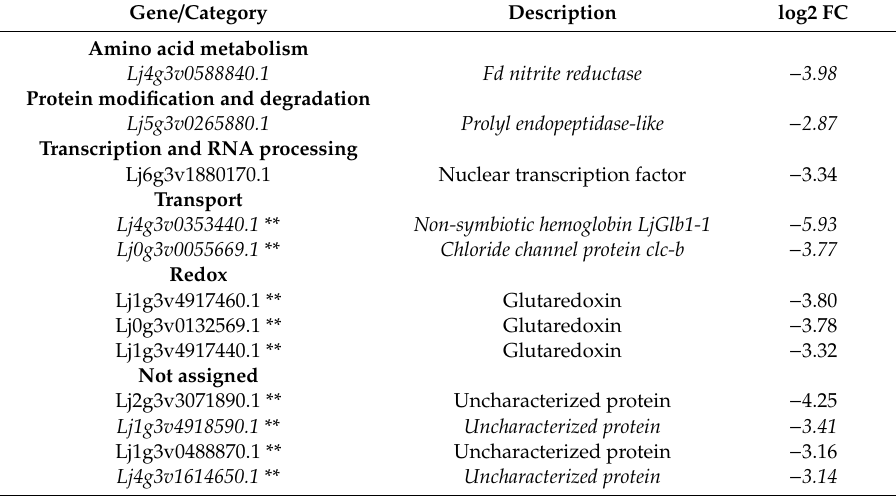
Table 4. Genes downregulated in shoot of Nod plants compared to shoot of NN plants. The fold change (FC) in expression levels is expressed as the log 2 of the di ff erence in relative expression levels of Nod–NN. Genes without a previously proposed role in nodule function and / or development are highlighted with two asterisks. Italic font is used to highlight the genes from the left cluster of Figure 4.